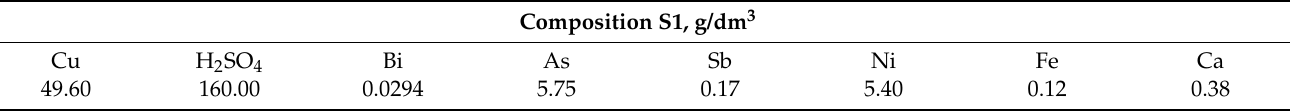
Table 1. Composition of industrial copper electrolyte used in